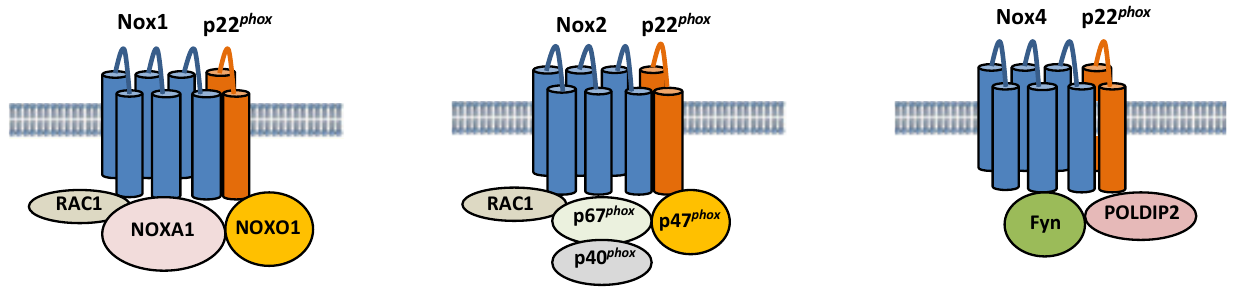
Figure 1. Composition of Nox1, Nox2, and Nox4. Nox1, 2, and 4 are six-transmembrane proteins. Nox1 forms a complex with p22 phox , Noxo1, Noxa1, and Rac, and its activity is regulated by the interaction. The activity of Nox2 is also regulated by interaction with cytosolic factors, such as p40 phox , p47 phox , p67 phox , and Rac1. The activity of Nox4 is positively and negatively regulated by POLDIP2 and Fyn, respectively.